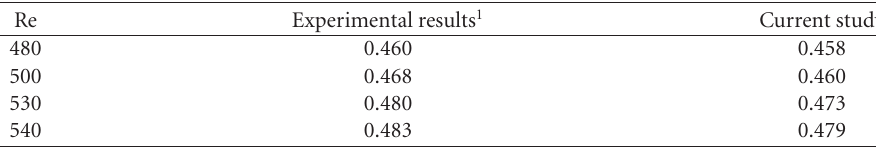
Table 4.1. Comparison of the current results with experiments.